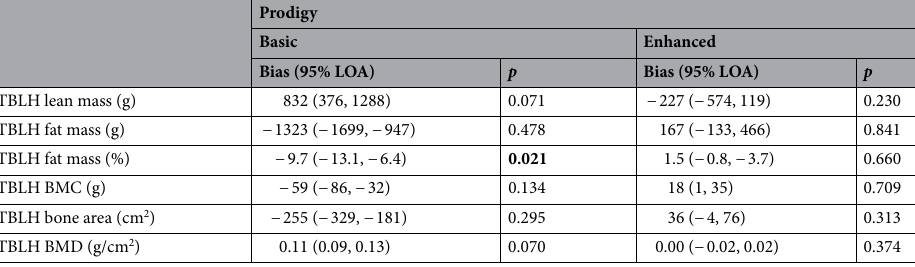
Table 3. Bland–Altman analysis comparing total body less head (TBLH) body composition parameters of young children measured by dual-energy X-ray absorptiometry (DXA) on the GE Lunar Prodigy, analysed using basic and enhanced analysis in reference to scans obtained on the GE Lunar iDXA. Significant values are in [bold].